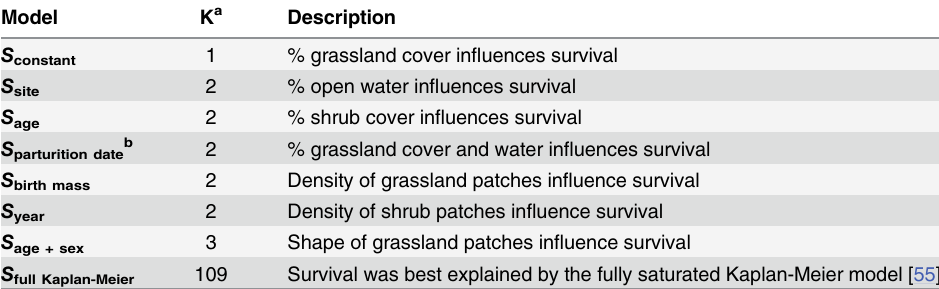
Table 3. A priori candidate models constructed to determine potential effects of intrinsic variables on survival of neonatal pronghorn in western South Dakota, USA, 2002 – 2005. Model